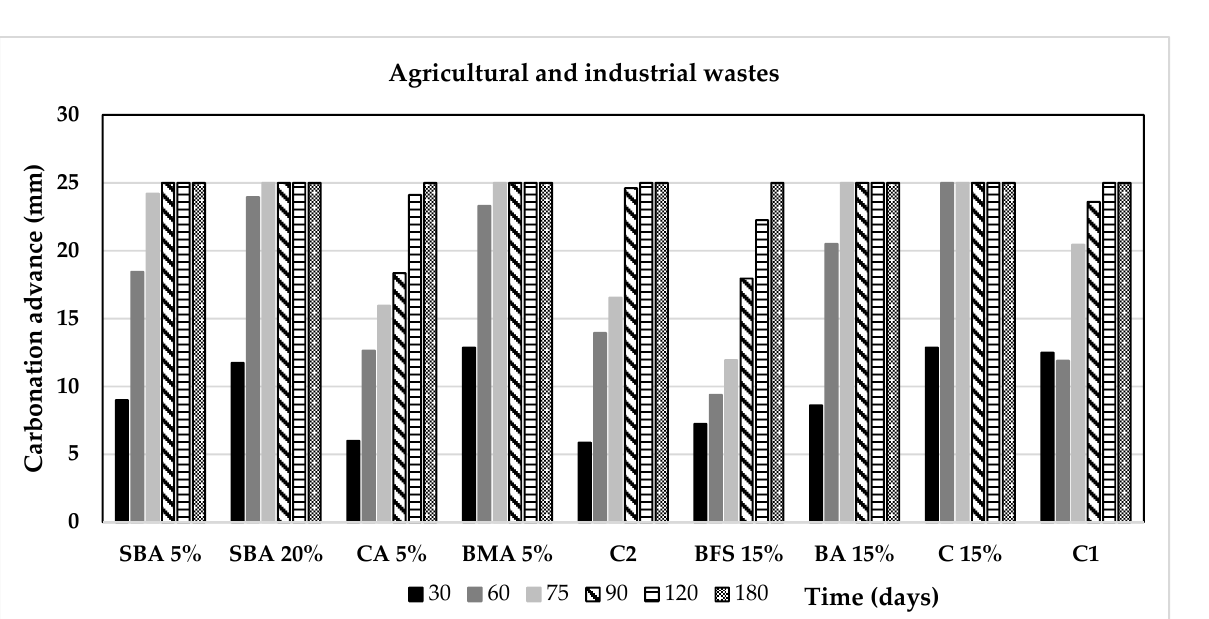
Figure 9. Advance of the carbonation front as a function of the time for the agricultural and industrial wastes group of additions.